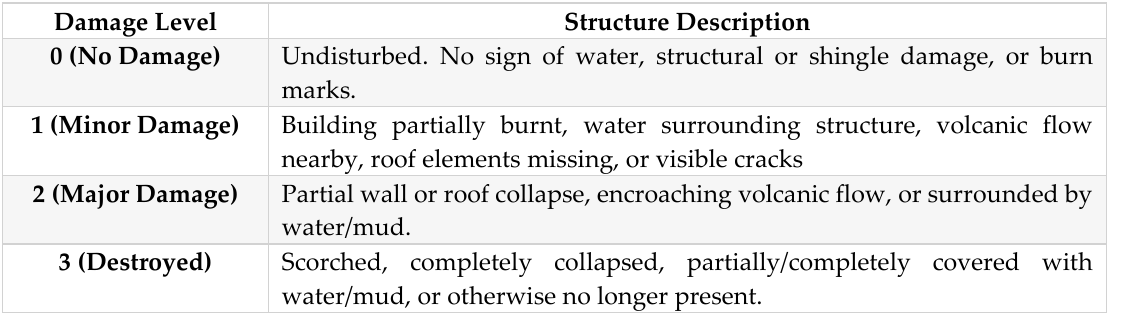
Figure 1. Damage levels and their descriptions [29]. Table 1. Proportion of each category.